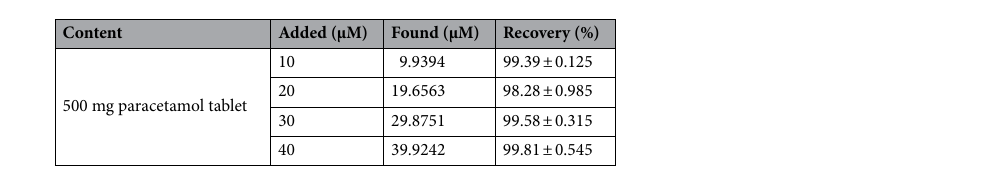
Table 3. Evaluation of PA in tablet using